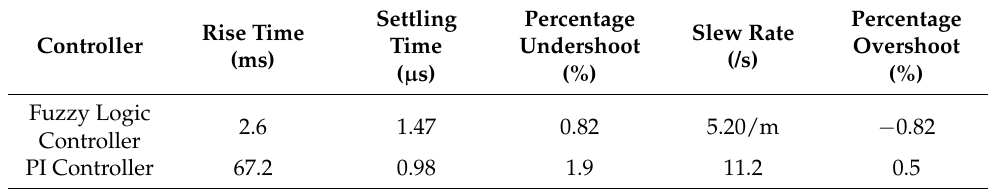
Table 8. Comparison between FLC and PI Controller for Step